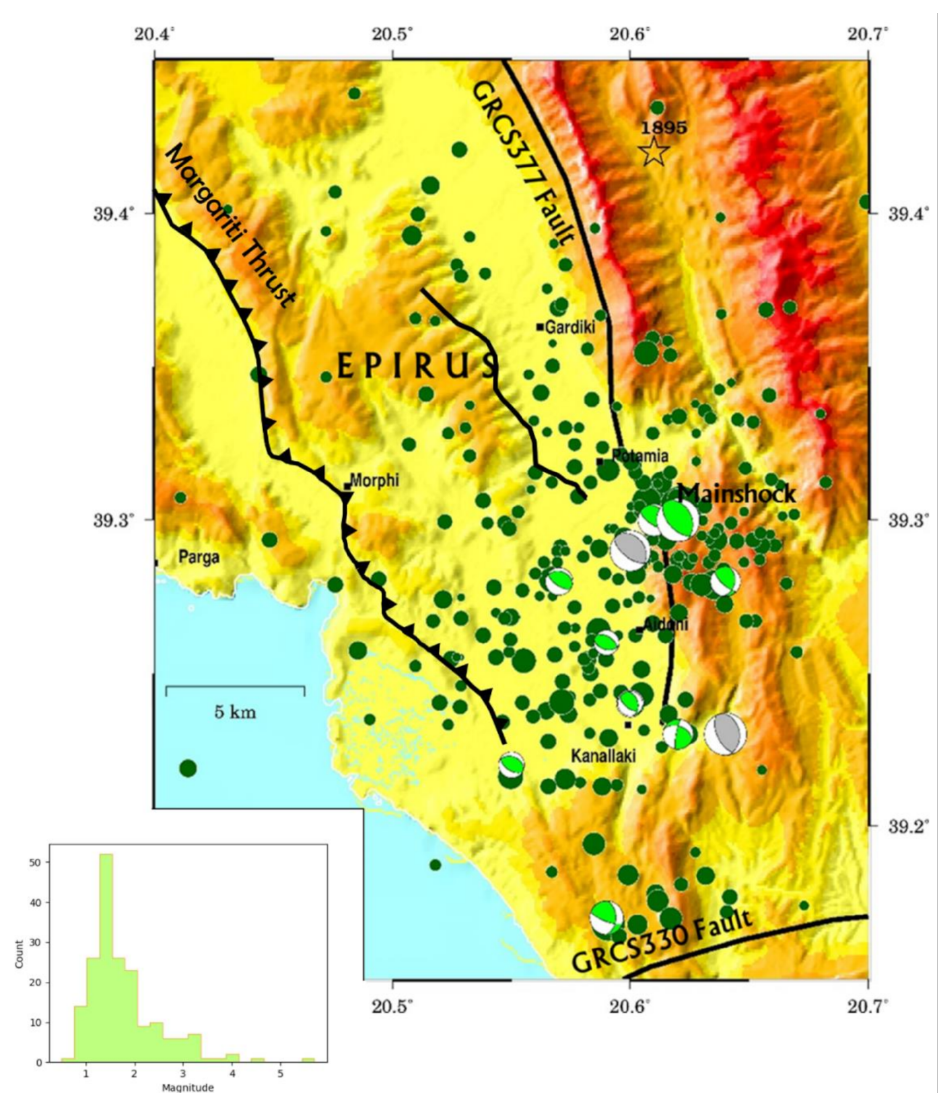
Figure 2. Spatial distribution of the Kanallaki 2020 sequence (green dots) for the period March– November 2020. Beach balls are focal mechanisms of the sequence (green) alongside previous available solutions (grey) for earthquakes with Mw > 5.0. The location of the Mw~6 event of 1895 is also shown (asterisk). The Margariti thrust fault sketch is based on [1], and GRCS330 and GRCS377 faults are from the GreDaSS Fault database [17]. The inset shows the magnitude histogram of the